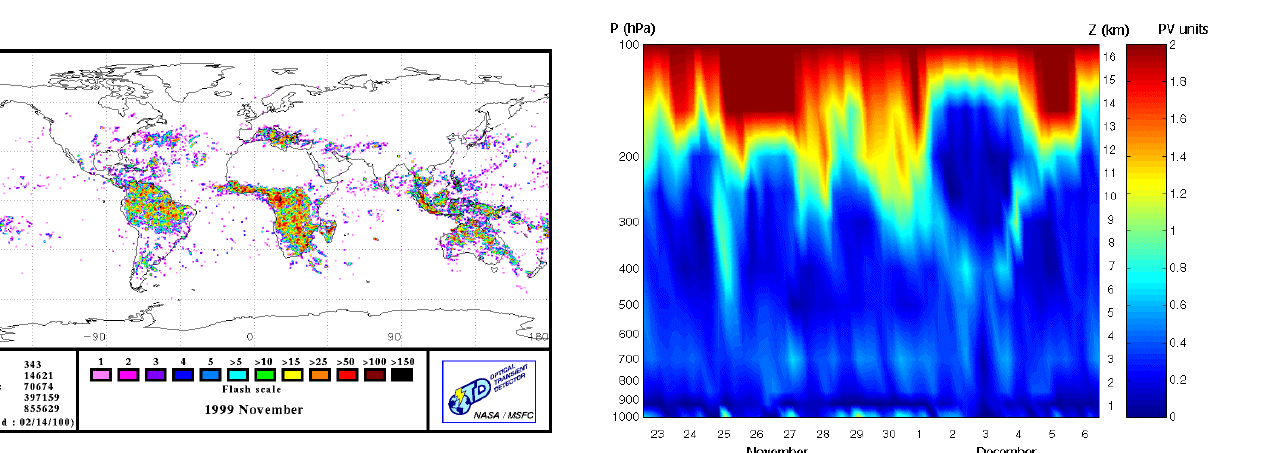
Lightning data for November 1999 detected by the Optical Transient Detector. Data provided by web site at http://thunder.nsstc.nasa.gov/data.